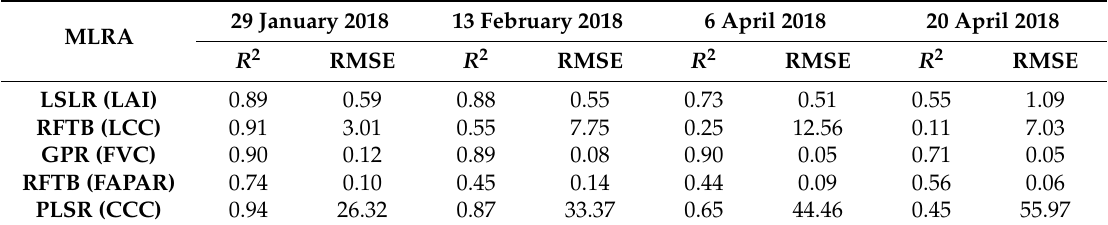
Table 6. Ground validation estimation results at each ground sampling date, for the best performing algorithms for the Maccarese test